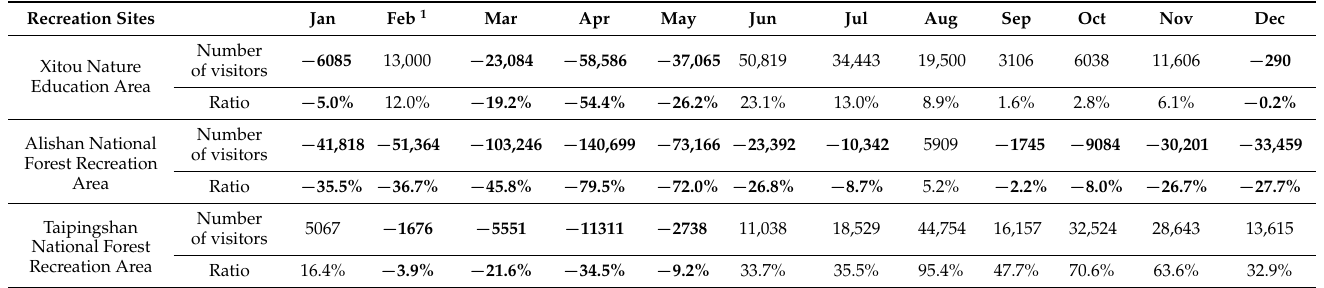
Table 1. Comparison of visitation numbers to top five forest recreation sites between average of